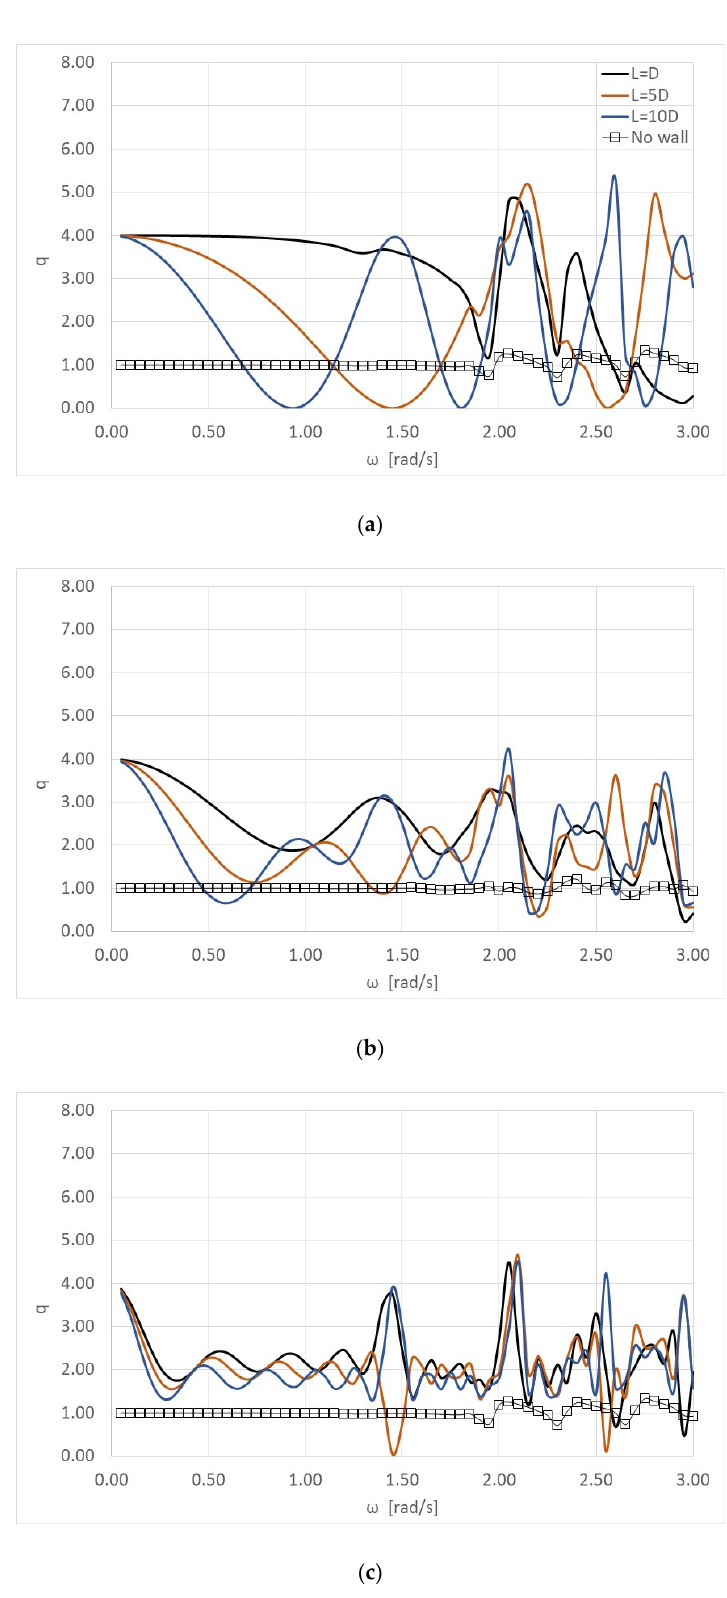
Figure 10. The q factor term of the WEC array, against ω , for the three different WEC–wall distance cases and for 45° wave heading angle. Comparison concerning the q factor of the same array without the presence of the breakwater: ( a ) parallel arrangement; ( b ) rectangular arrangement; ( c ) perpendicular arrangement.